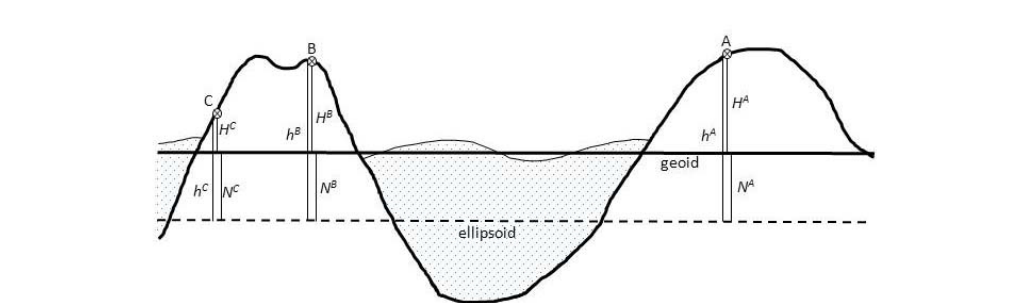
Figure 1. The principle of “GPS-leveling”: Three points A, B and C are shown; B and C are located on one continent. For each of the three points the ellipsoidal heights h as derived from geodetic space positioning, and the geoid height N are given. The orthometric heights can directly be deduced using Eq. (1)